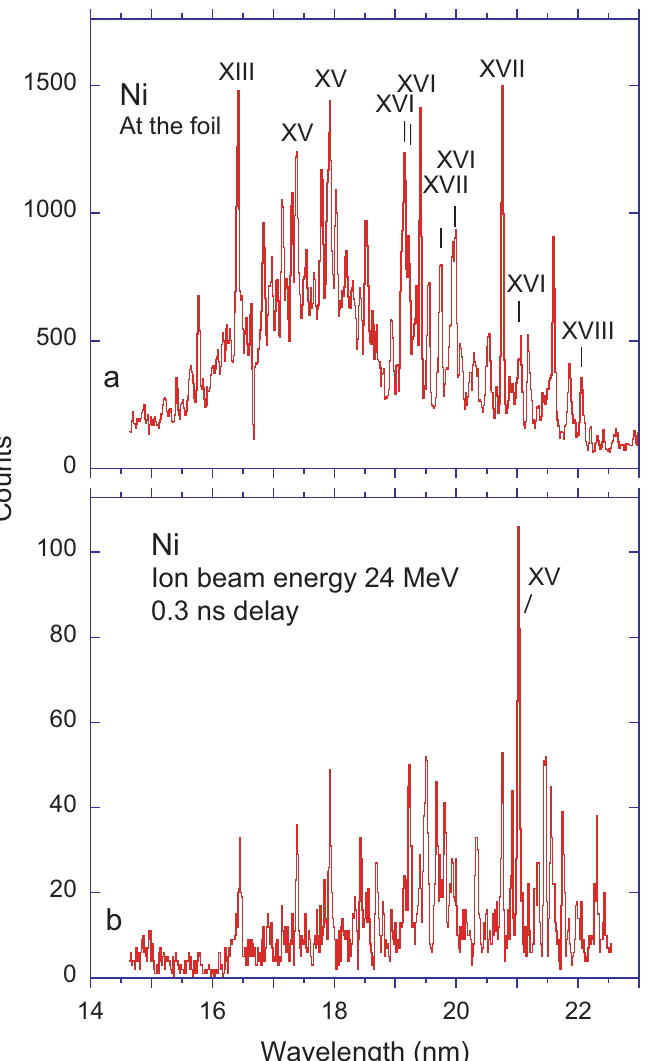
Figure 17. Beam–foil spectra of Ni at an ion beam energy of 24 MeV. Slit width 60 µ m, line width (FWHM) 0.045 nm. The charge state distribution peaks near q = 13–14+, and ion charge states q = 10 + to q = 18 + are expected to contribute. The figure refers to the same raw data as Figure 5 of [56]. ( a ) Observation at the foil; ( b ) Observation of the ion beam 3 mm downstream of the foil, corresponding to a delay of about 0.3 ns after the spectrum in ( a